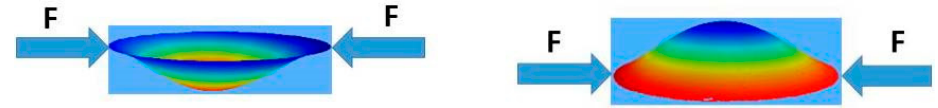
Figure 1. The possible ground states of bistable membranes measured with a Whitelight